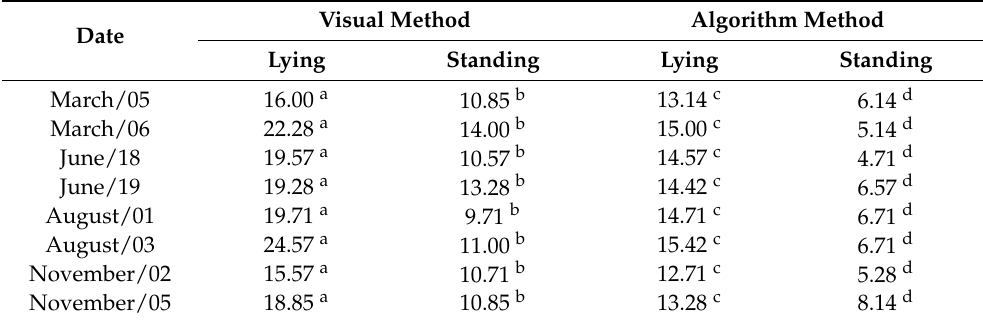
Table 3. Measures of central tendency (median) of the data obtained through the computational method and the visual method, referring to the lying and standing positions. Visual Method Algorithm Method Date Lying Standing